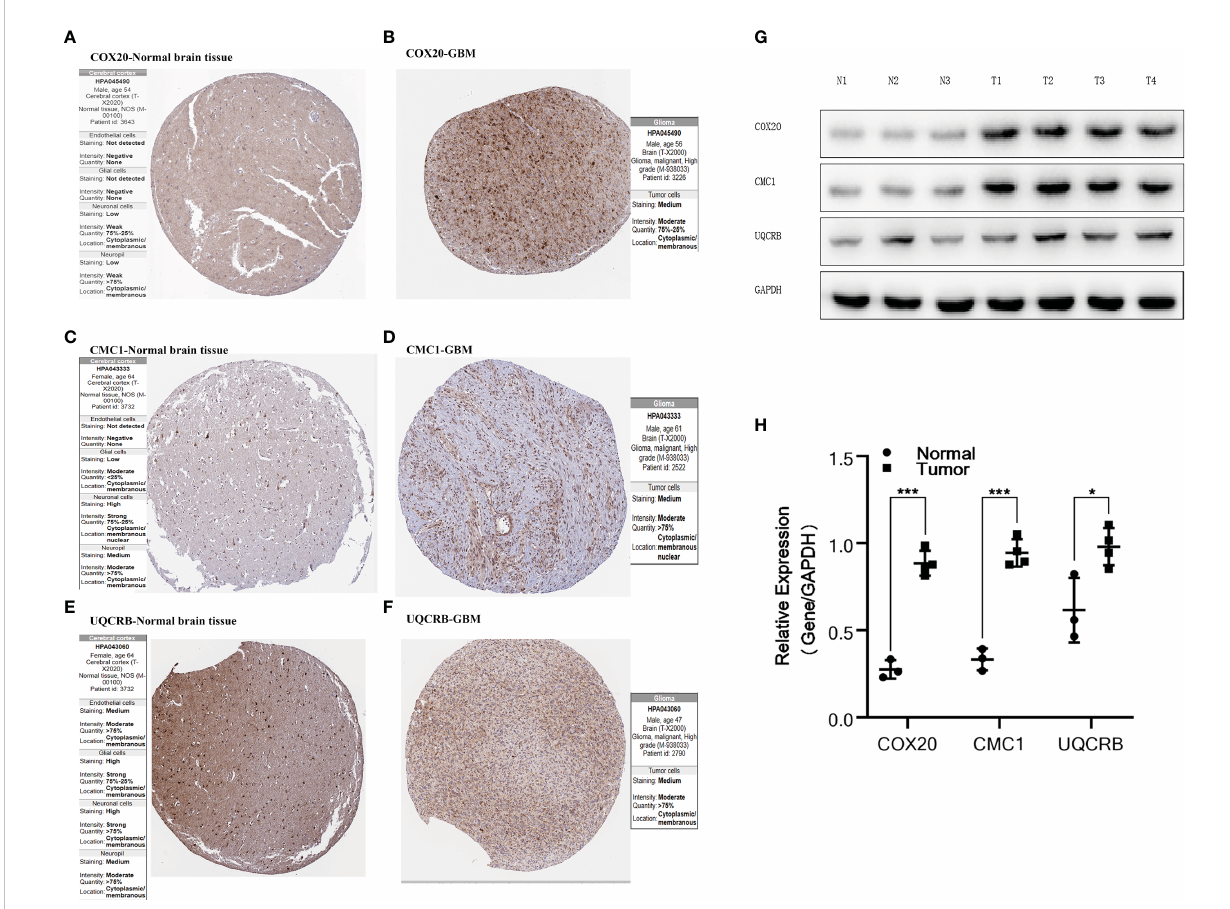
FIGURE 5 Validation of protein expression by HPA database and Western Blot. (A, B) Expression of COX20 in normal brain tissue and glioma; (C, D) Expression of CMC1 in normal brain tissue and glioma; (E, F) Expression of UQCRB in normal brain tissue and glioma. (G, H) Expression of COX20, CMC1 and UQCRB in three normal tissues and four tumor tissues and differential analysis. P values (* < 0.05; *** <